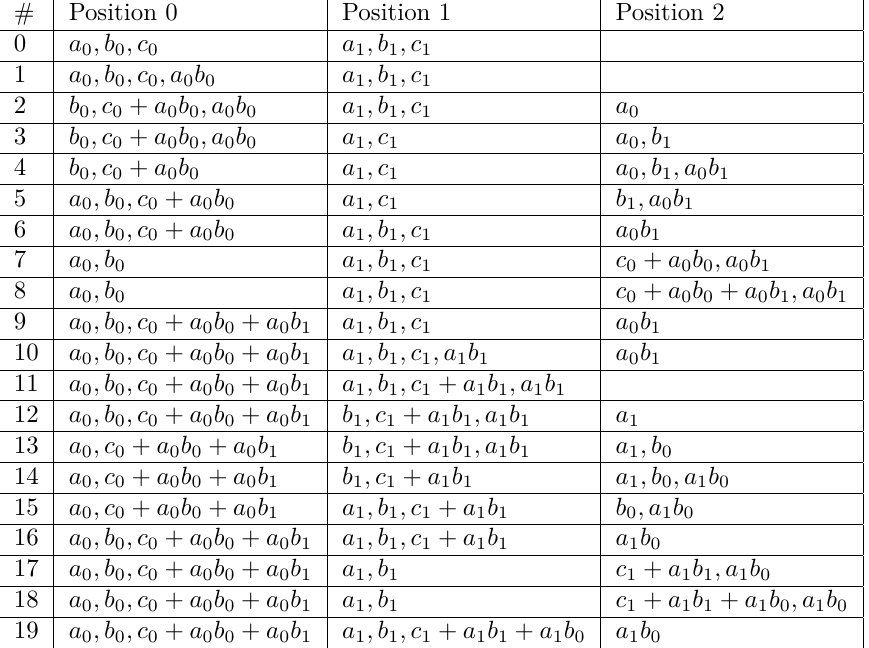
Table 2: Probed variables per cycle of the Toffoli gate